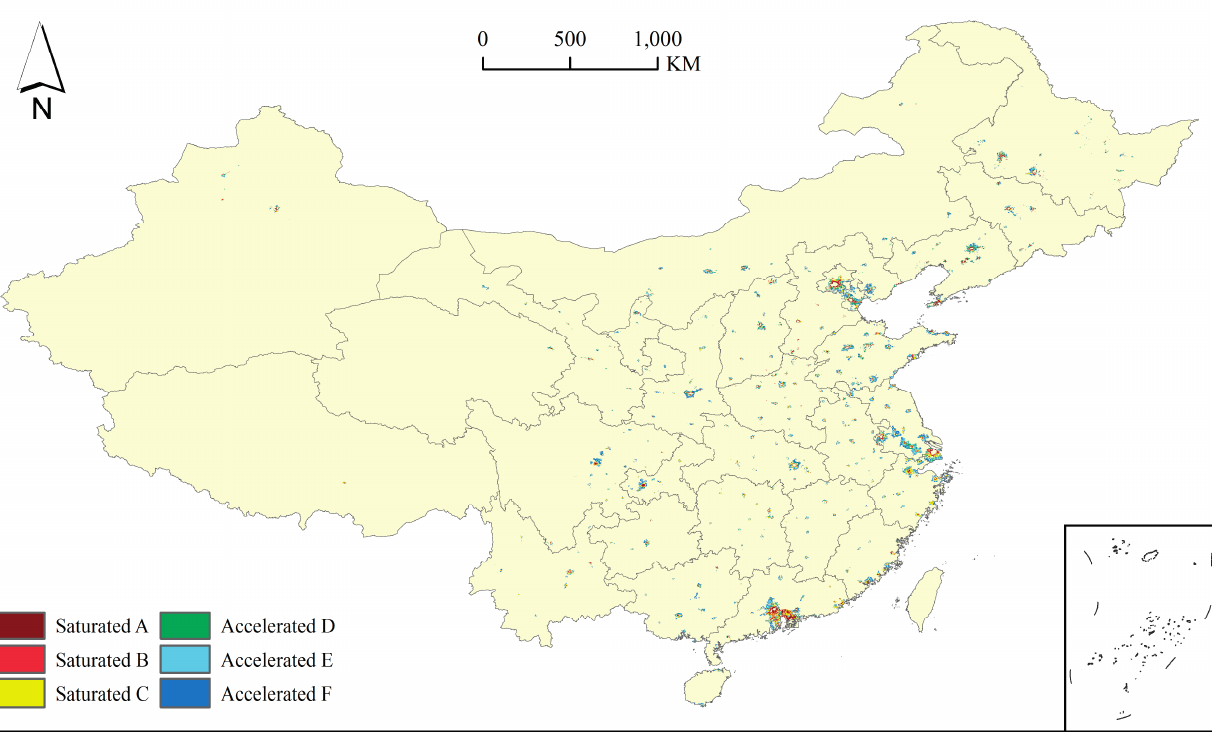
Figure A1. Six patterns of NTL time series: saturated patterns A–C and accelerated patterns D–F to demonstrate spatial differentiation of urbanization in China.